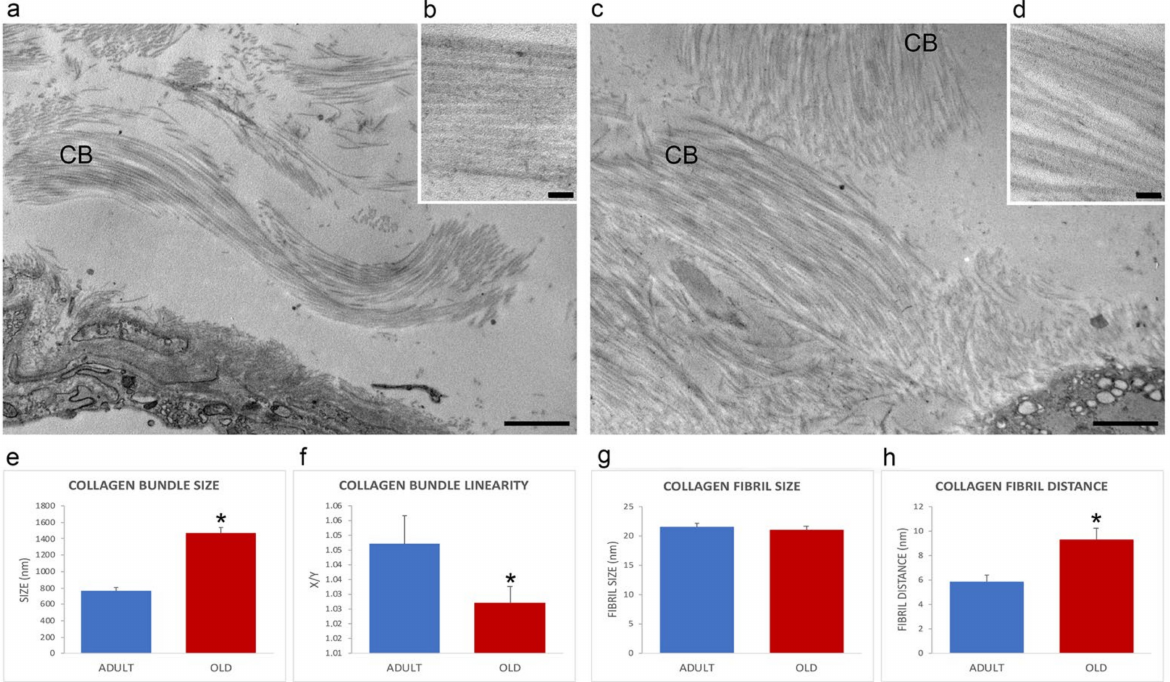
Figure 3. Ultrastructural images ( a – d ) of the perimysium of adult ( a , b ) and old ( c , d ) gastrocnemius muscle. CB, collagen bundle. ( a , c ), bars: 1 µ m; ( b , d ), bars: 100 nm. Morphometric analysis of collagen bundles and collagen fibrils features are reported in the histograms ( e – h ). X/Y, ratio between the real length of the collagen bundle profile and the corresponding linear length. * p <